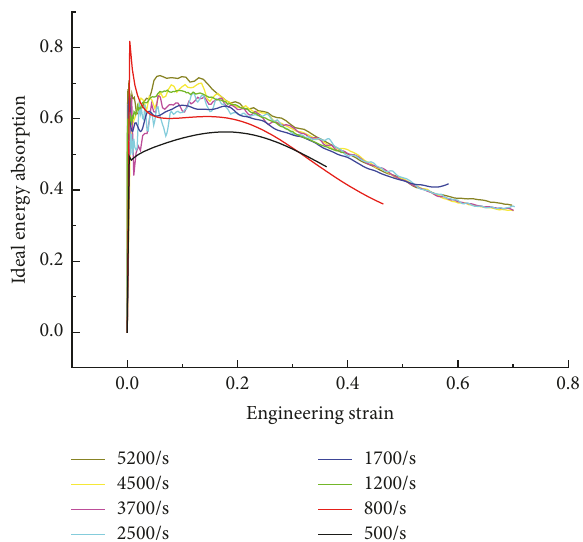
Figure 11: Curves of ideal energy absorption efficiency of high- damping rubber.